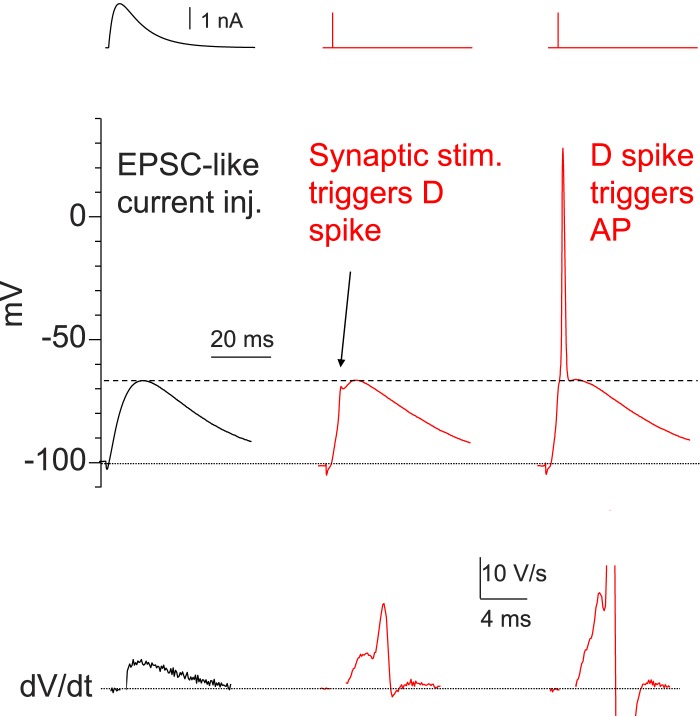
Dendritic Na+ spikes are necessary to fire APs in CA2 PNs.Sample traces of somatic voltage response in a CA2 neuron to EPSC-like current injection (left) or a PP stimulus (middle and right, the same stimulation strength). Bottom: dV/dt of the corresponding traces on top. Constant negative current injection was applied to hyperpolarize the membrane potential to ∼−100 mV.